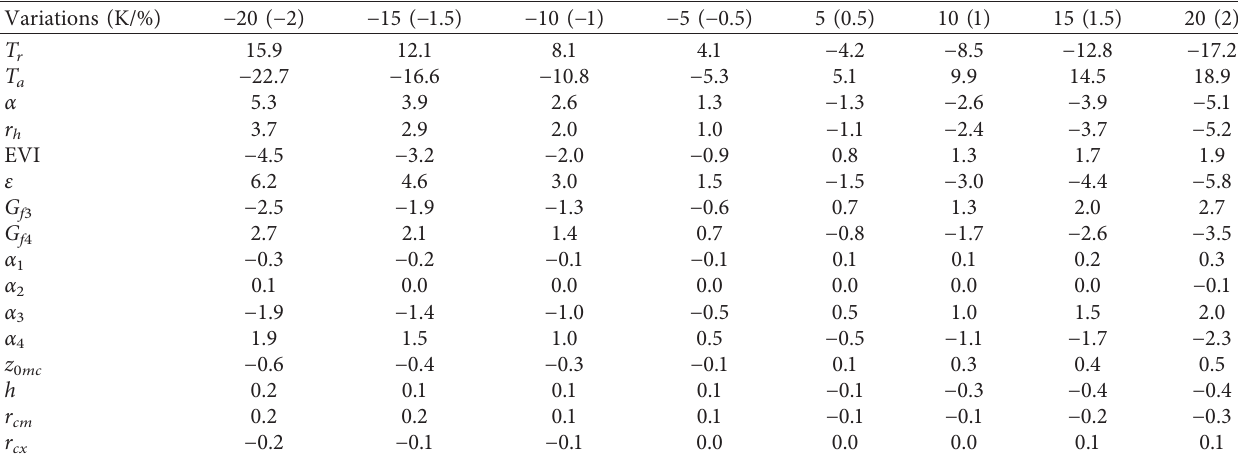
Table 5: Sensitivity S i (%) of LE estimates to each